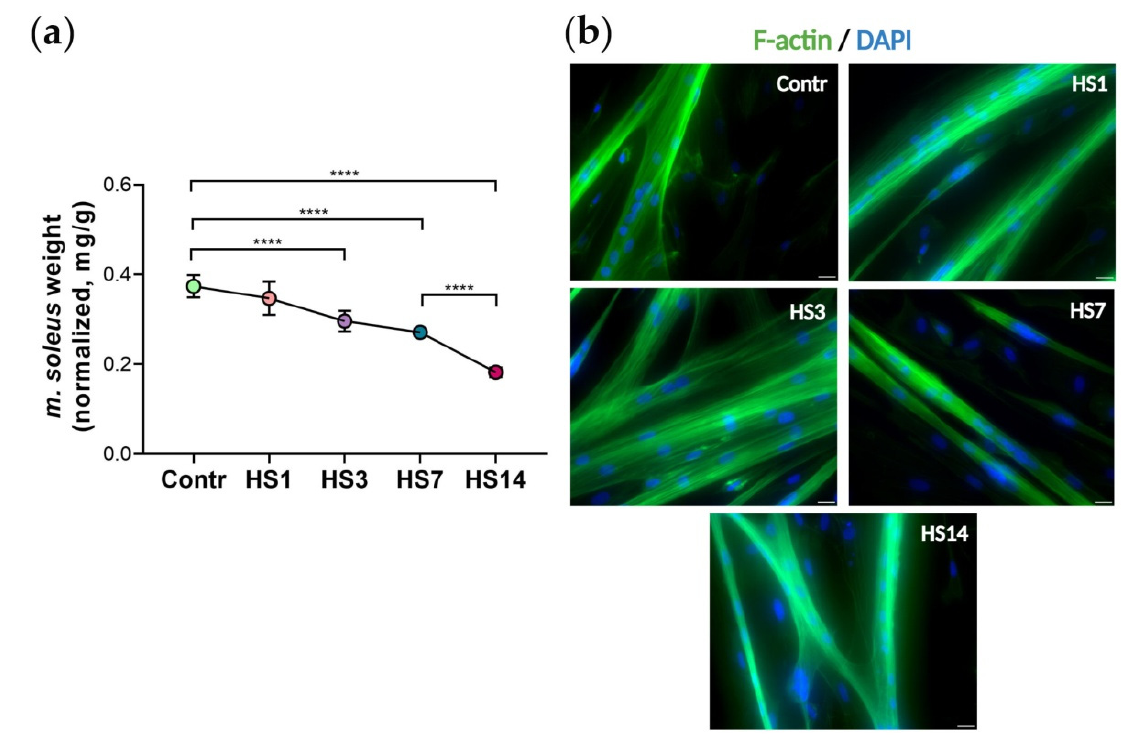
Figure 1. Changes in soleus muscle weight following 1, 3, 7 and 14 days of mechanical unloading (HS): ( a ) rat soleus muscle weight normalized to the body weight; n = 16, **** p < 0.0001; ( b ) Myogenic differentiation (the 5th day of differentiation) of myoblasts purified from control muscle and hindlimb suspended muscle (HS1, HS3, HS7, HS14). Myotube formation was visualized with F-actin antibody; scale bar = 20 µm.